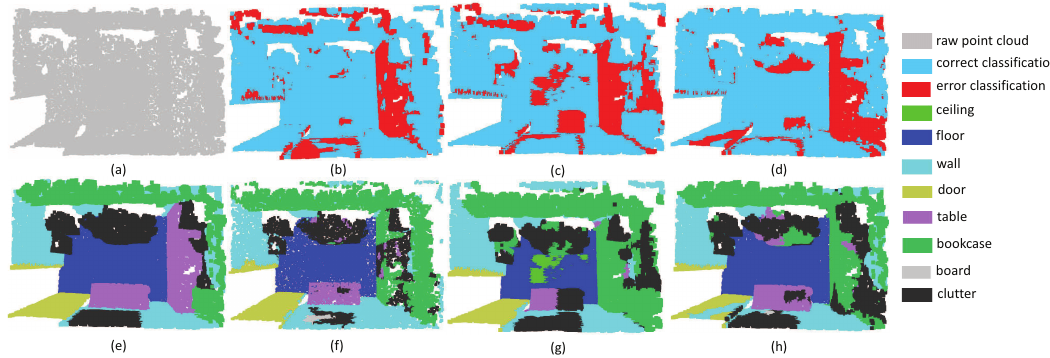
Figure 18. The segmentation results on CopyRoomS 3 D . ( a ) input, ( e ) ground truth, ( b , f ) the classification result by PointNet++, ( c , g ) the classification result by PointSIFT, and ( d , h ) the classification result by